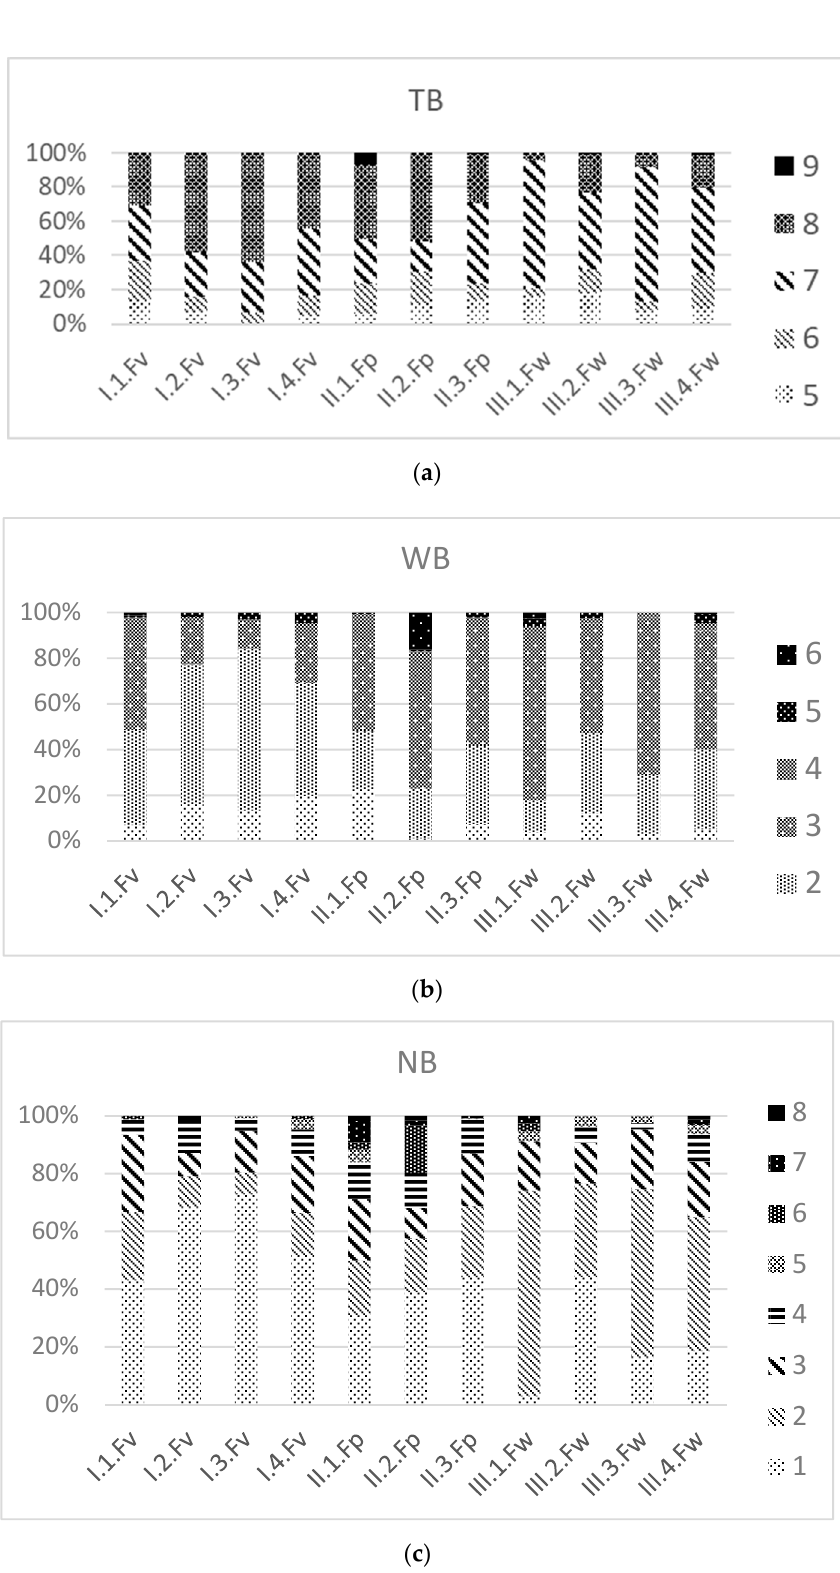
Figure 4. Proportions of the species based on relative ecological indices. ( a ) TB (relative temperature), ( b ) WB (relative water requirements) and ( c ) NB (nitrogen requirements). Festuca vaginata vegetation types: I.1.Fv: Little Hungarian Plain, I.2.Fv: northern part of Kiskunság, I.3.Fv: southern part